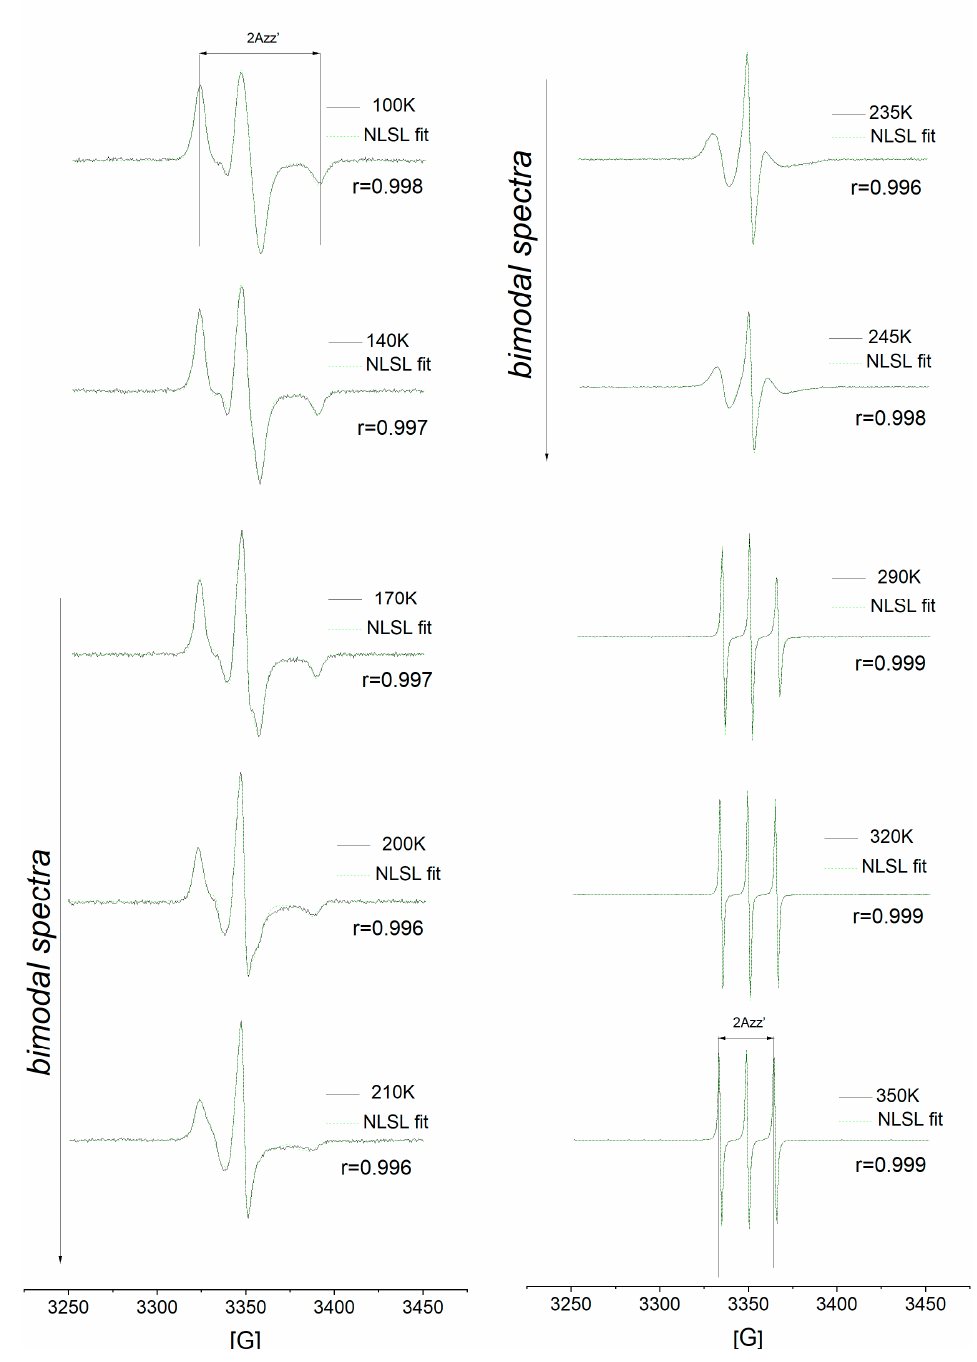
Figure 1. Spectral evolution of the spin system of cis -1,4-poly(isoprene) and TEMPO ( cis -1,4-PIP10k/TEMPO) at selected temperatures over the temperature range from 100 K to 350 K. The experimental data (black) and simulated (green) electron spin resonance (ESR) spectra of cis -1,4-PIP10k/TEMPO system within the slow motion regime at 100 K, 140 K, superimposed slow and fast motion regimes at 170 K up to 245 K and within the fast motion regime at 290 K up to 350 K are shown. The distance of the outer line separation, 2 A zz (cid:48) displays the double-sided